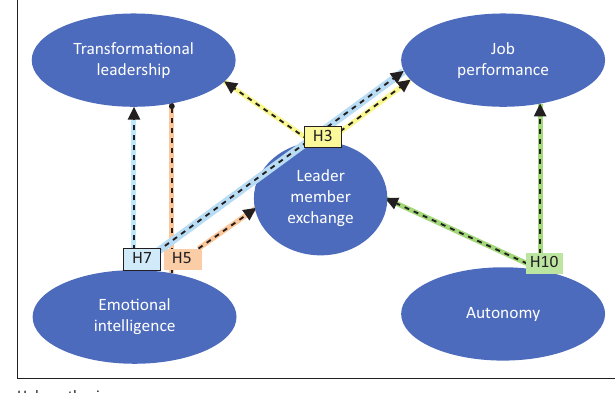
H, hypothesis. FIGURE 4: Mediated and moderated